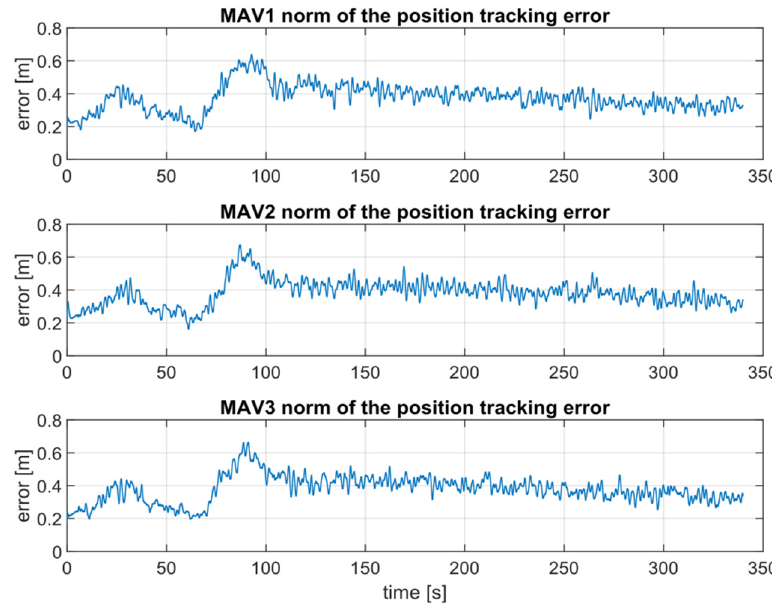
Figure 10. The norm of the tracking error for each UAV.